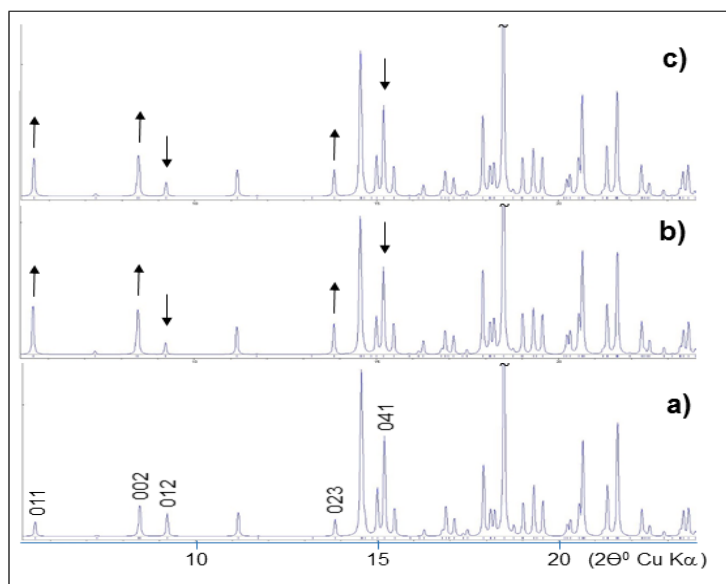
Figure 6. XRD patterns simulation obtained with PowderCell program: ( a ) original data of pickeringite, MgAl 2 (SO 4 ) 4 ·22H 2 O, with Mg:Mn occupancy of 0.93:0.07 [33]; ( b ) Mg:Zn occupancy, 0.5:0.5; ( c ) Mg:Fe, 0.5:0.5. The Miller indices are indicated for the lines that change the intensity, compared to the original data, with the variation indicated by arrows.